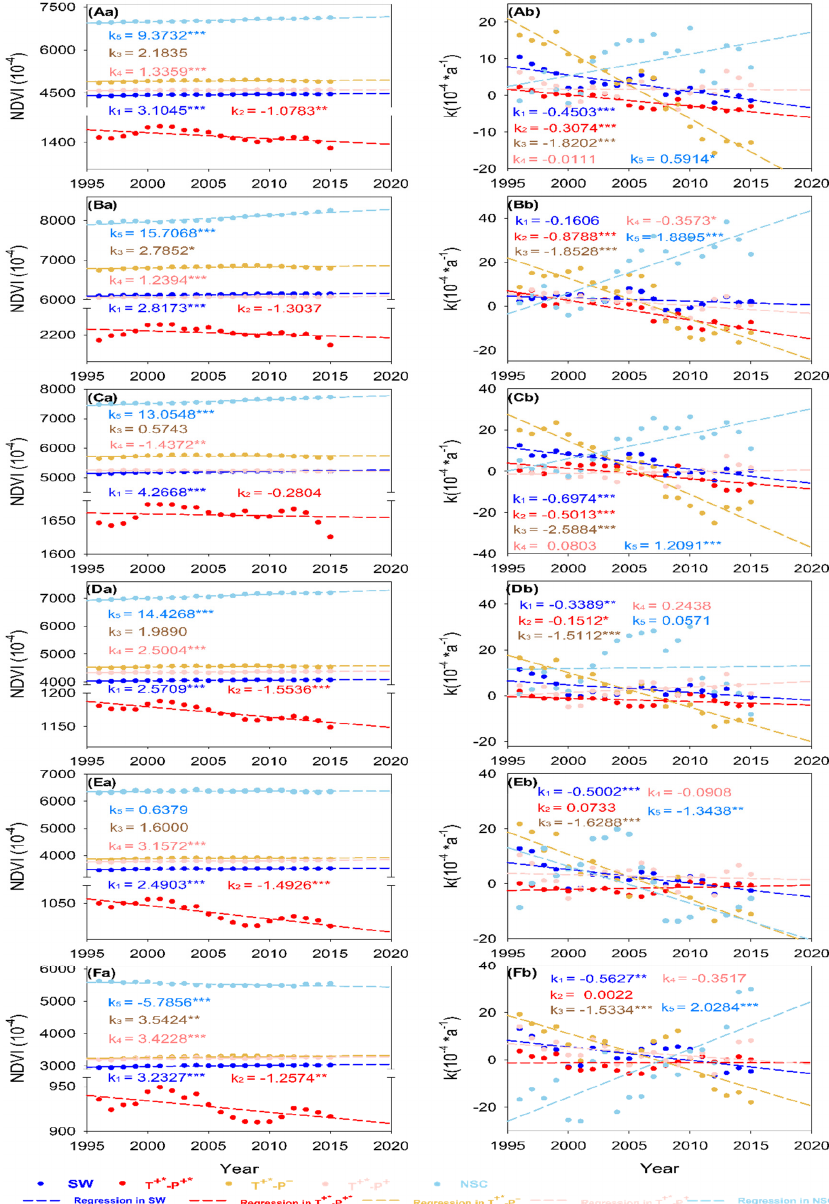
Figure 3. Interannual variation characteristics of NDVI and interannual trend k over 15 years of sliding. Capital letters ( A – F ) represent Mean, P 100 , P 75 , P 50 , P 25 and P 5 , respectively, and small letters ( a , b ) refer to the NDVI and interannual trend k over 15 years of sliding. Numbers 1–5, respectively, represent the SW, T +* -P +* , T +* -P − , T +* -P + and